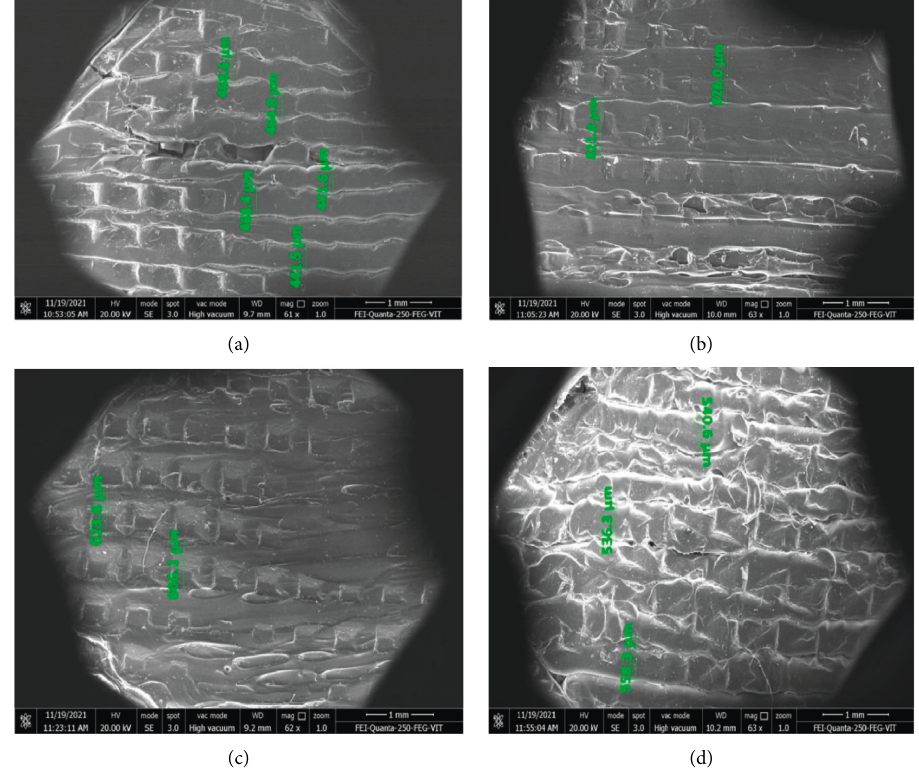
Figure 7: Microstructure of different optimized